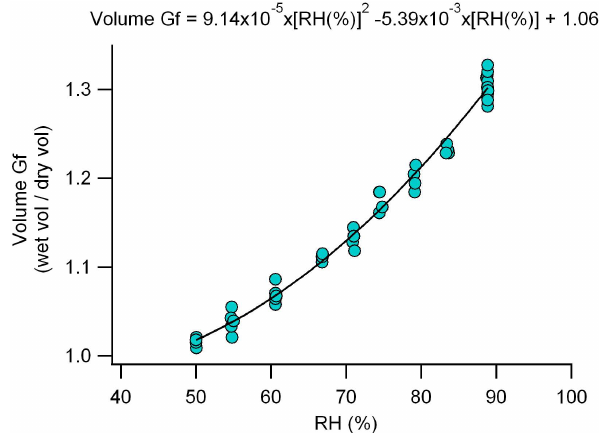
Fig. 7. Humidogram of SOA formed by the photooxidation of toluene + NO x under a dry condition (Run 1499B).